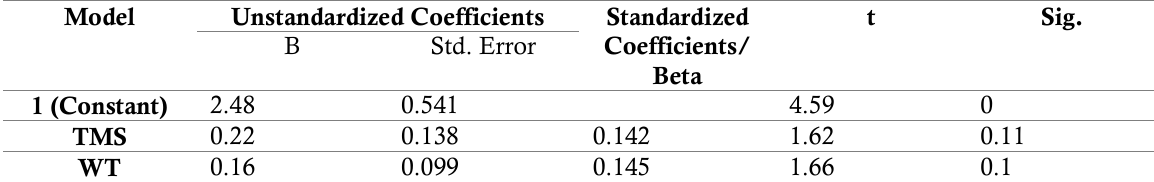
Table 6 . Regressions Weight of the Independent Variables